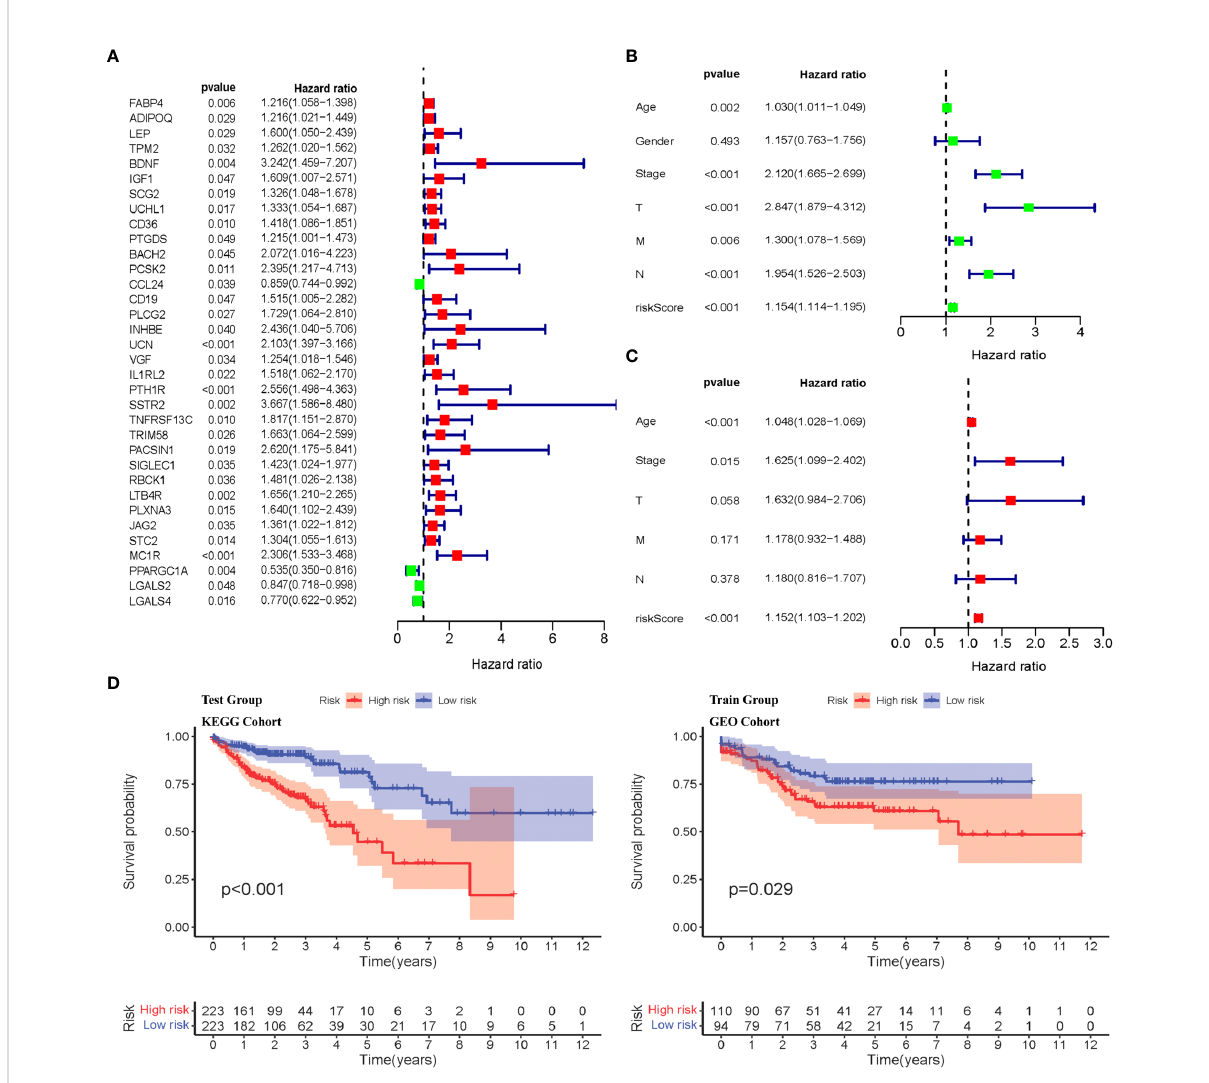
FIGURE 2 Identi fi cation of immune-related diffrentional genes via Cox regression and K-M analysis of IRGPI subgroups. (A) Univariate Cox analysis of 34 immune-related hub genes ( p < 0.05). (B, C) Univariate and multivariate Cox regression analysis on IRGPI riskscore and other clinicopathologic variables. (D) Kaplan – Meier survival analysis between IRGPI subgroups in the TCGA cohort and GEO cohort ( p <